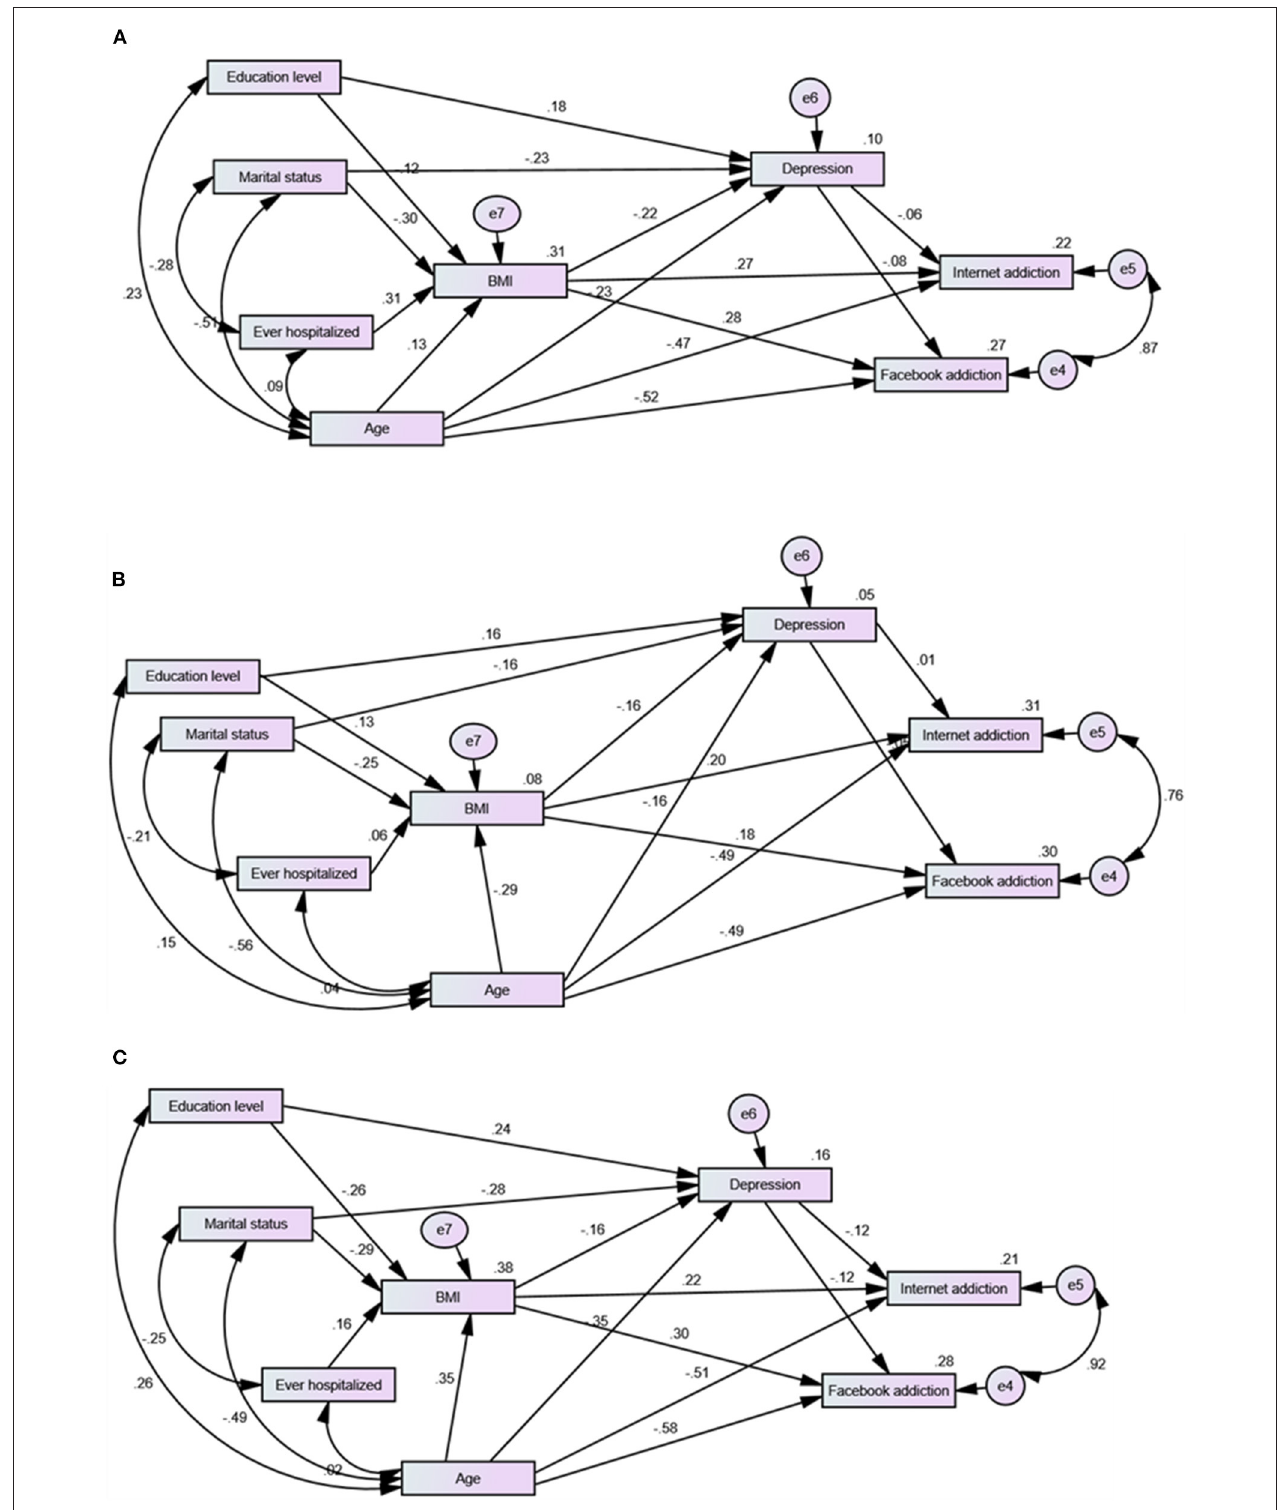
FIGURE 2 | Direct effects from structural equation model predicting depression, internet addiction, and Facebook addiction among women with different eating disorders (A) , with anorexia nervosa (B) , and with other eating disorders (C) .